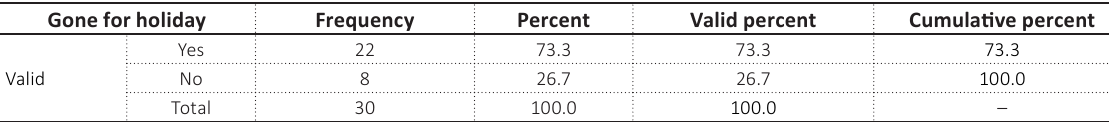
Table A1. Ecotourist holiday